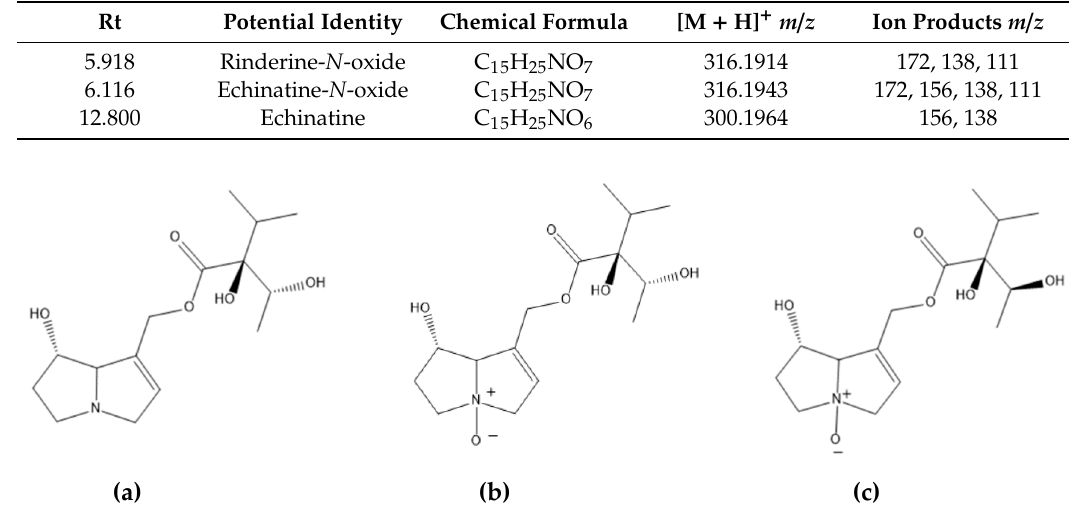
Figure 3. The structures of identified PA/PANOs: ( a ) echinatine, ( b ) echinatine N-oxide, ( c ) rinderine N-oxide.